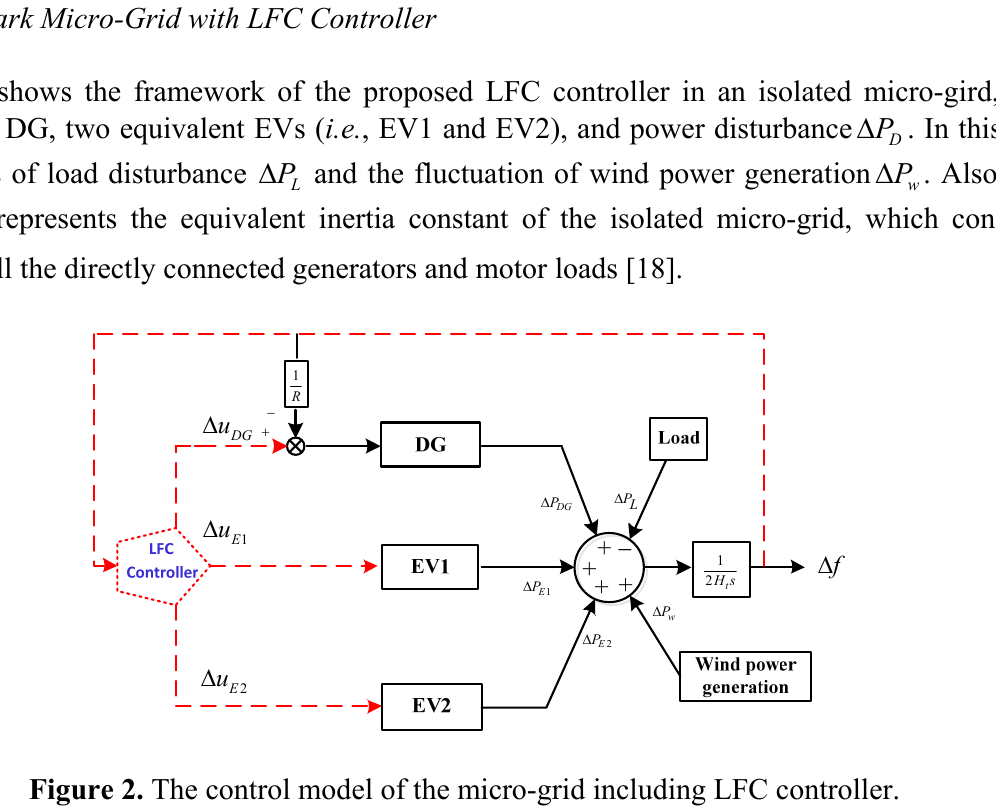
Figure 1. The model of the benchmark micro-grid.